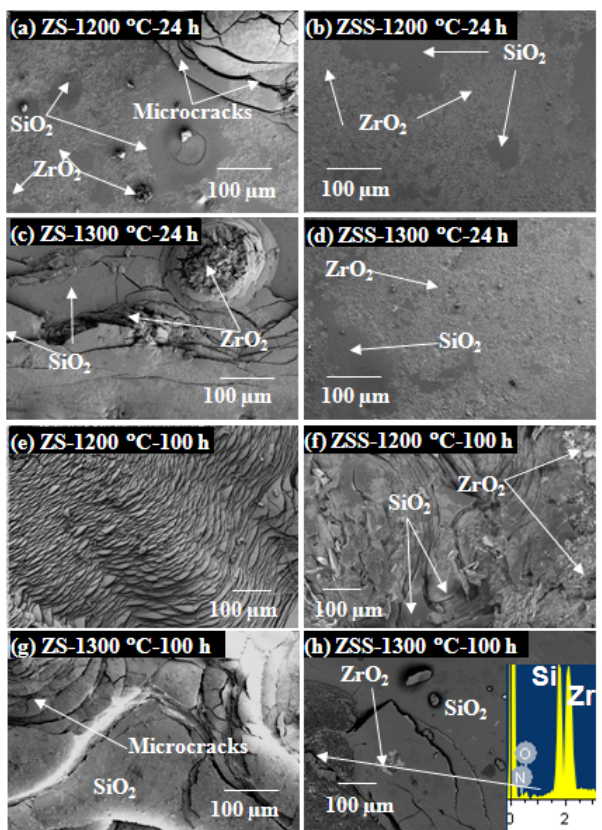
Figure 4. SEM micrographs depicting morphology of the surfaces of the oxide scales formed by isothermal oxidation in air on: ( a ) ZS at 1200 °C for 24 h; ( b ) ZSS at 1200 °C for 24 h; ( c ) ZS at 1300 °C for 24 h; ( d ) ZSS at 1300 °C for 24 h; ( e ) ZS at 1200 °C for 100 h; ( f ) ZSS at 1200 °C for 100 h; ( g ) ZS at 1300 °C for 100 h; and ( h ) ZSS at 1300 °C for 100 h. Oxide products are mainly composed of ZrO 2 and silica rich glassy phases. Several micro ‐ cracks are observed on the oxide surfaces. The density of micro ‐ cracks is more on ZS composite, whereas the amount of silica reaching the glassy layer is higher on ZSS composite.